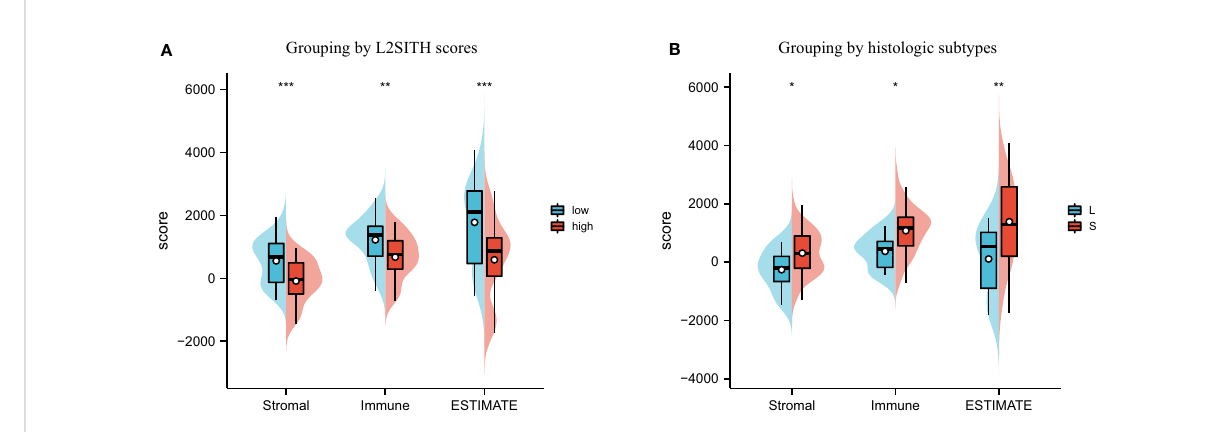
FIGURE 7 Tumor purity estimation of LUAD samples grouped by L2SITH score and histologic subtype. (A) Stromal, immune, and ESTIMATE scores of high- and low-scored groups. (B) Stromal, immune, and ESTIMATE scores of lepidic and solid histologic subtypes. The symbol * indicates statistical signi fi cance at the 0.05 level (p<0.05), ** indicates the level of signi fi cance 0.01 (p<0.01), *** indicates the level of signi fi cance 0.001 (p<0.001).